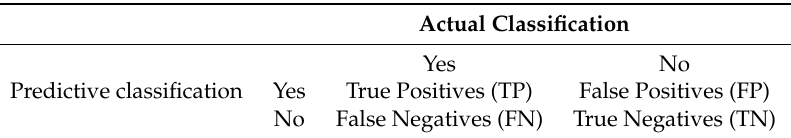
Table 1. The evaluation of the methods are done following: the reprojection error, the segmentation error and the outliers ratio. Table 1. Confusion